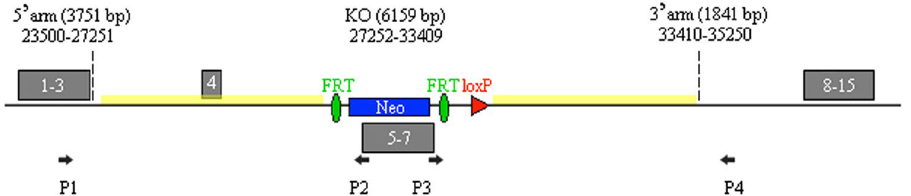
Figure 6. Schematic of the GGNBP2 KO targeting vector. The GGNBP2 KO vector was designed to replace GGNBP2 from exon 5 to exon 7 (6159 bp, from bp 27252 to bp 33409 of ENSMUST00000100685) with a Neo expression fragment that results in the destruction of all potential open reading frames of GGNBP2 expression isoforms. The numbers in the gray shadows are the exon numbers of GGNBP2. Two homologous arms (3751 bp 5 ′ arm from bp 23500 to bp 27251 of ENSMUST00000100685, 1841 bp 3 ′ arm from bp 33410 to bp 35250 of ENSMUST00000100685) flank the Neo expression frame. One loxP and two FRT sites are located near the terminus of the Neo expression frame. P1 (GGNBP2 specific), P2 (Neo specific), P3 (Neo specific) and P4 (GGNBP2 specific) were the primers used to amplify the targeted